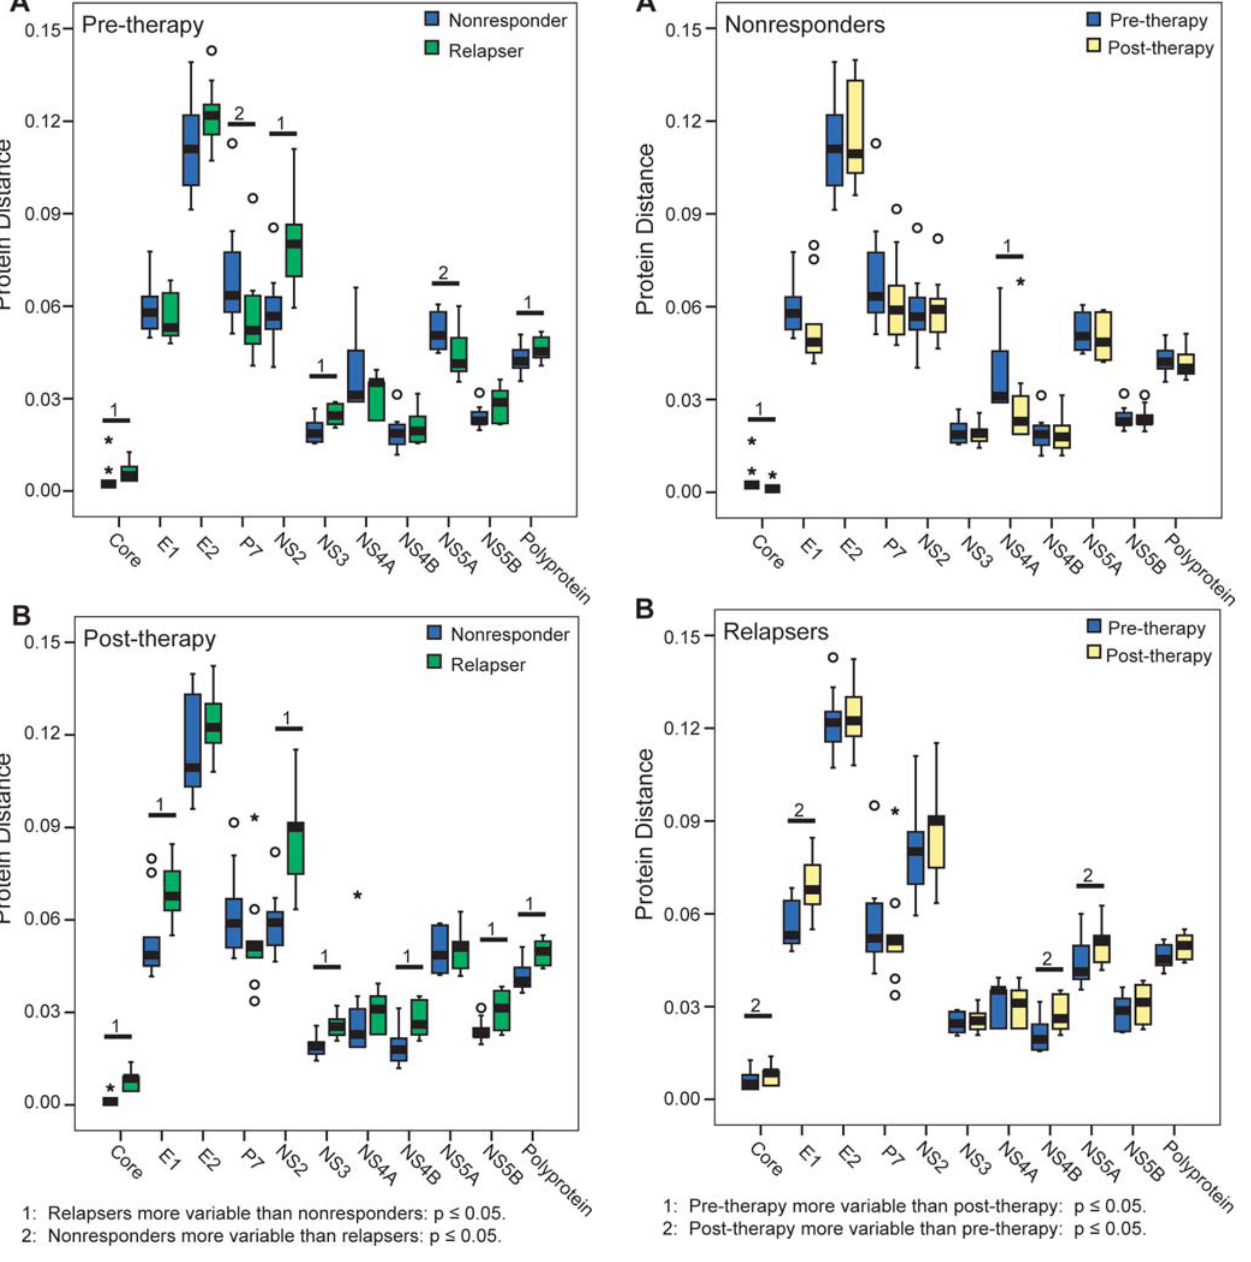
Figure 3. Protein distance among the nonresponder and relapsers sequences. The mean protein distance among the nonresponders and relapsers was compared, and the statistical significance was evaluated using the Mann-Whitney test. A) Pre- therapy. B) Post-therapy.